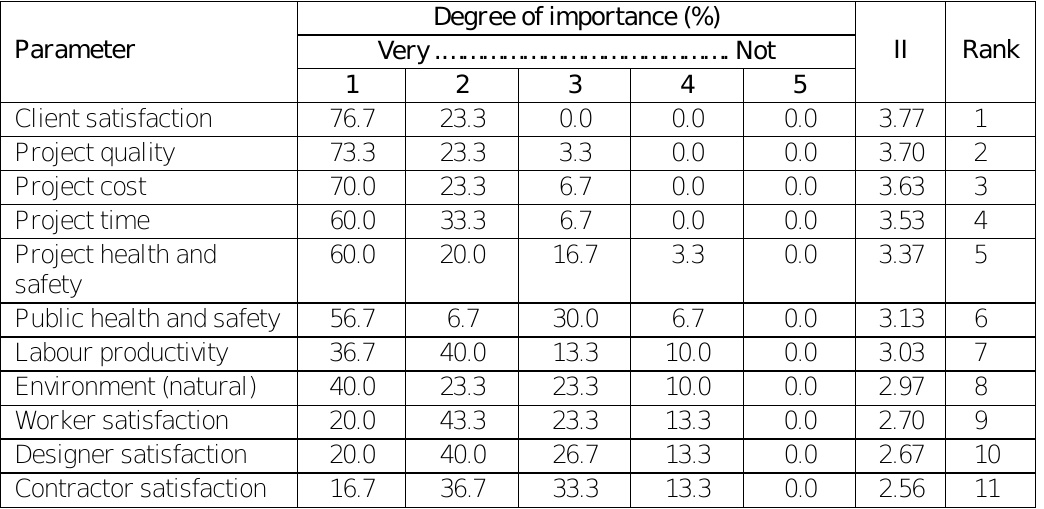
Table 2: Importance of various project parameters to